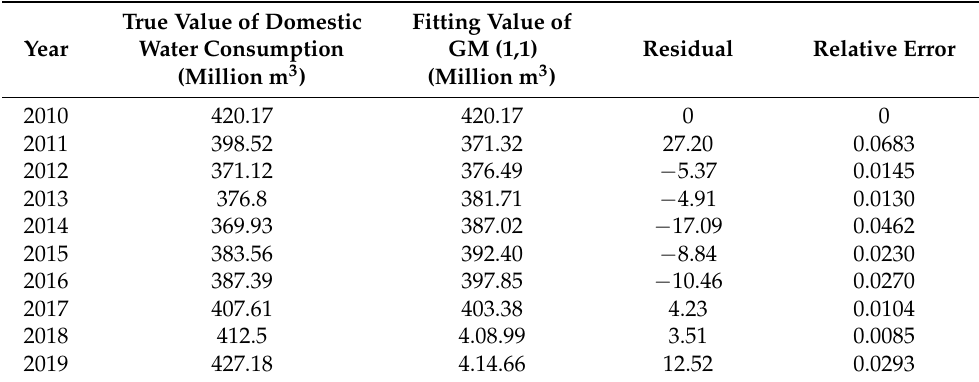
Table 12. Fitting results of domestic water demand prediction model in Changsha city from 2010 to 2019.